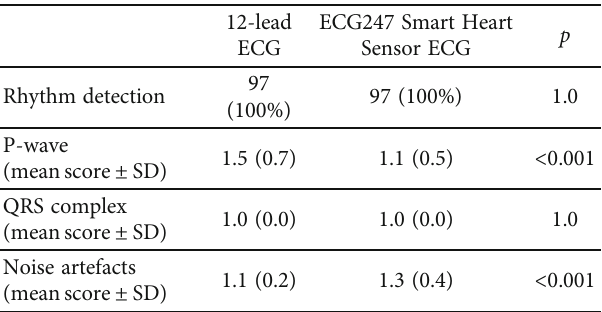
Table 2: ECG quality score ∗ and the possibility to determine heart